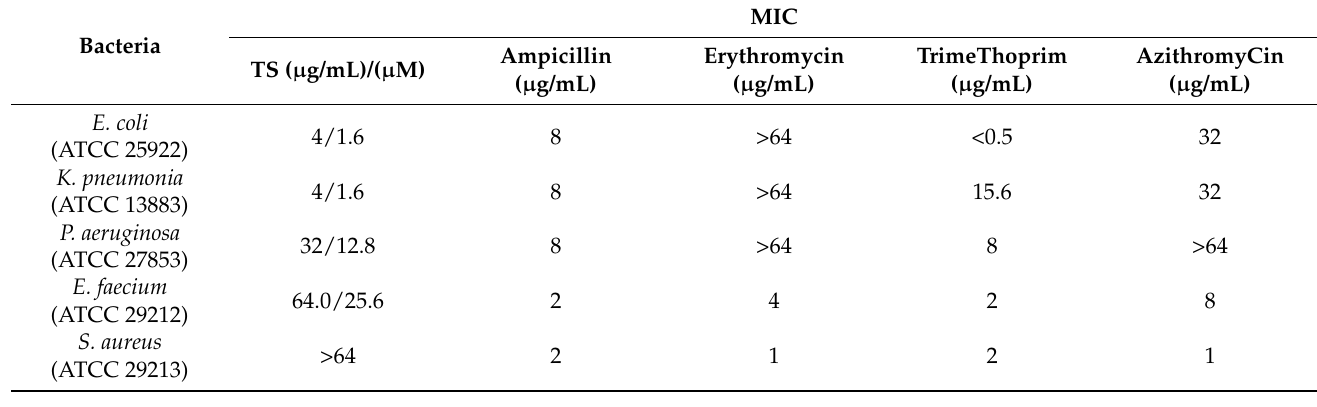
Table 1. Minimum inhibitory concentration (MIC) values of TS and other antibiotics.